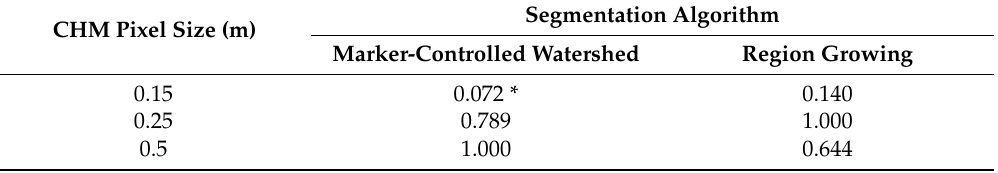
Table 10. p values from the Wilcoxon signed rank test after Holm–Bonferroni correction, comparing results from the two segmentation algorithms (marker-controlled watershed and region growing).